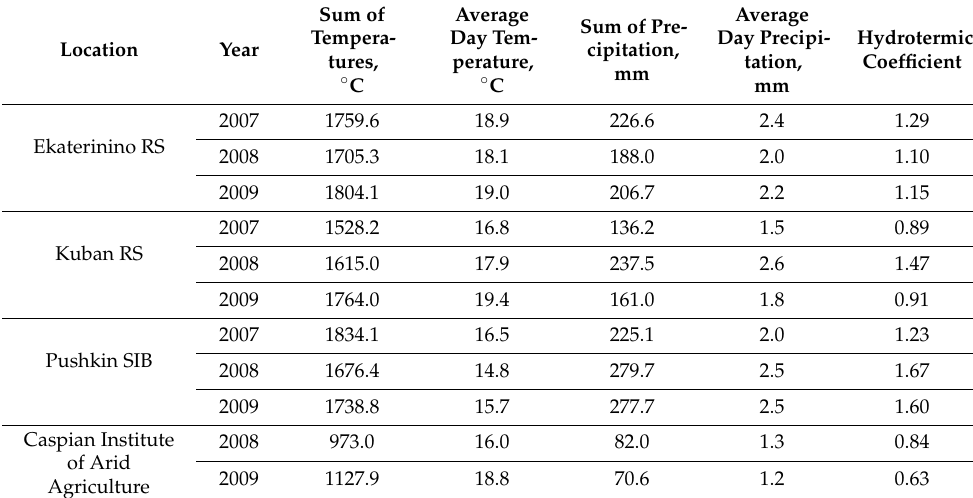
Table 2. Climatic conditions of the